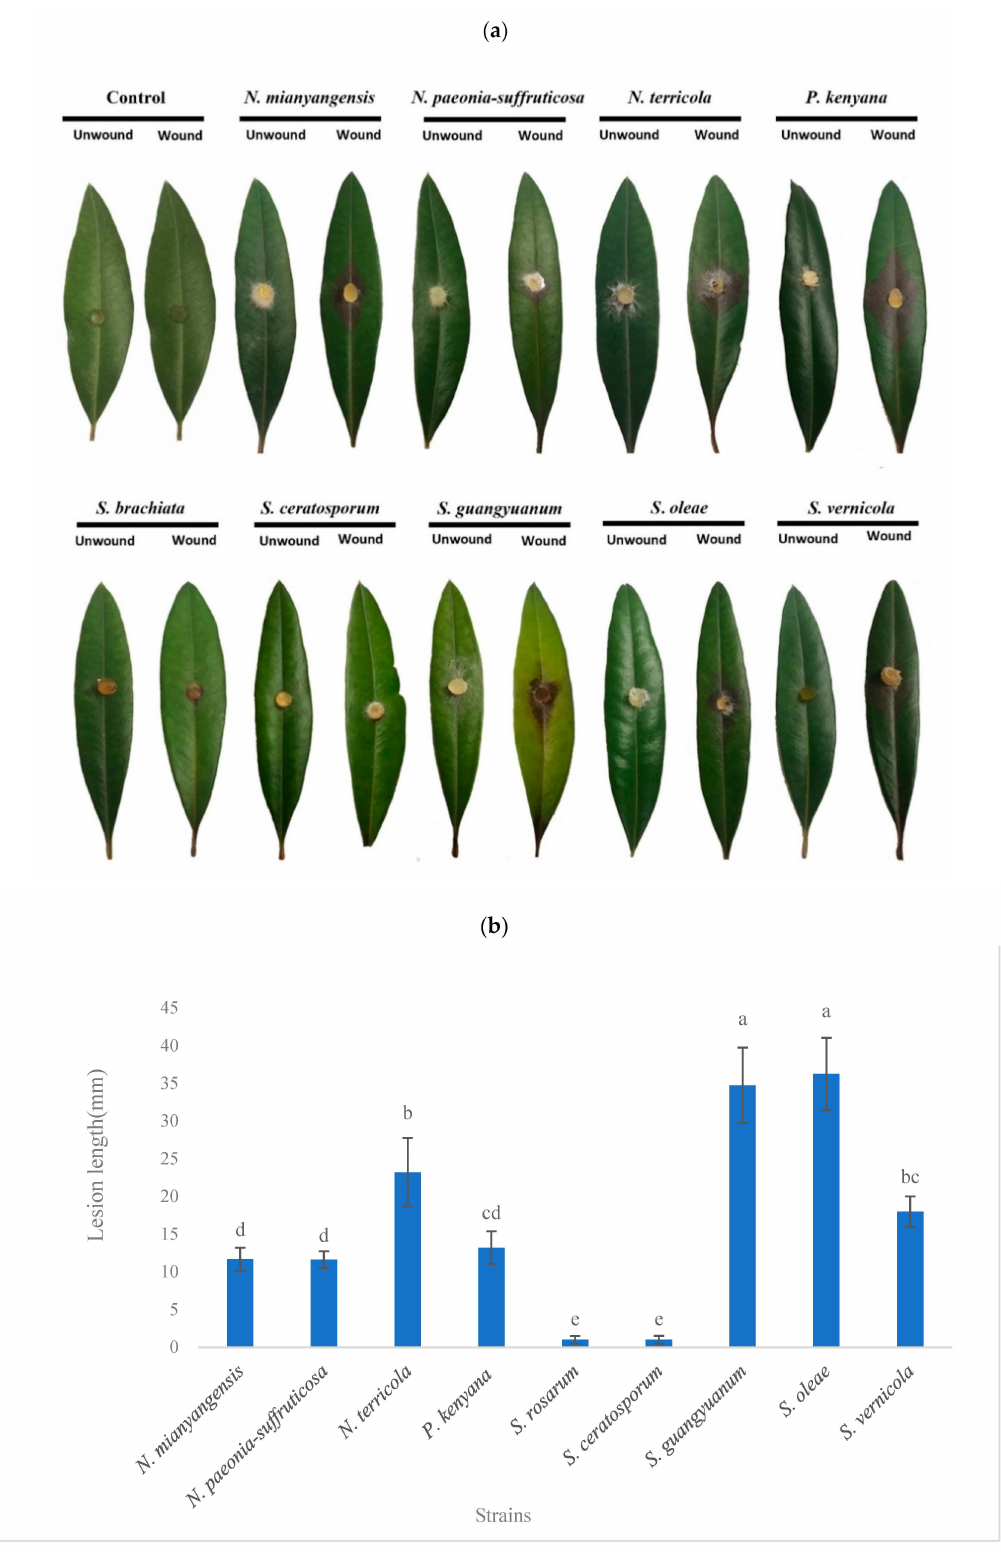
Figure 17. Pathogenicity test results of nine pestalotiod species on olive leaves. ( a ) Induced symptoms on wounded and unwounded olive leaves after 7 d. ( b ) Virulence of the isolates was evaluated by measuring lengths of the necrotic lesions in millimeters on infected olive leaves after 7 d. Error bars indicate the standard deviation of the mean. Significant differences ( p < 0.05) between means are indicated with different letters according to Duncan’s multiple range